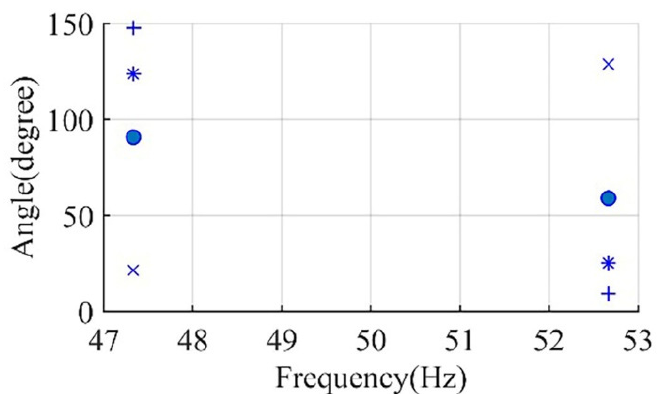
Figure 4. Motor I phase angle of left sideband and right sideband components for healthy conditions at inertia of; inertia of 0.063 kg·m 2 (*), inertia of 0.63 kg·m 2 ( ● ), inertia of 0.93 kg·m 2 (×), and inertia of 5.7 kg·m 2 (+).